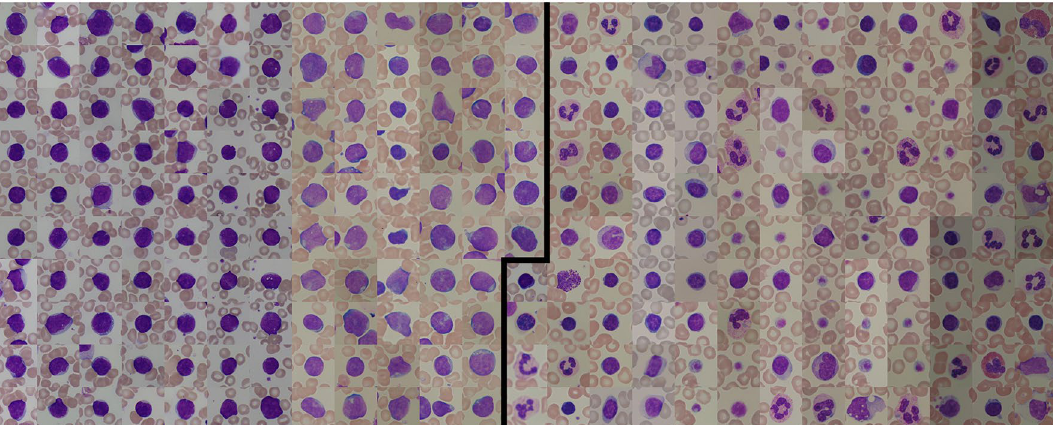
Figure 1. The ALL dataset of 250 single-cell images from Labati et al. 15 used in this study. Blast cell images from ALL patients on the left are separated by a black line from thrombocytes and non-malignant leukocytes from healthy individuals on the right. Each image has a size of 257 × 257